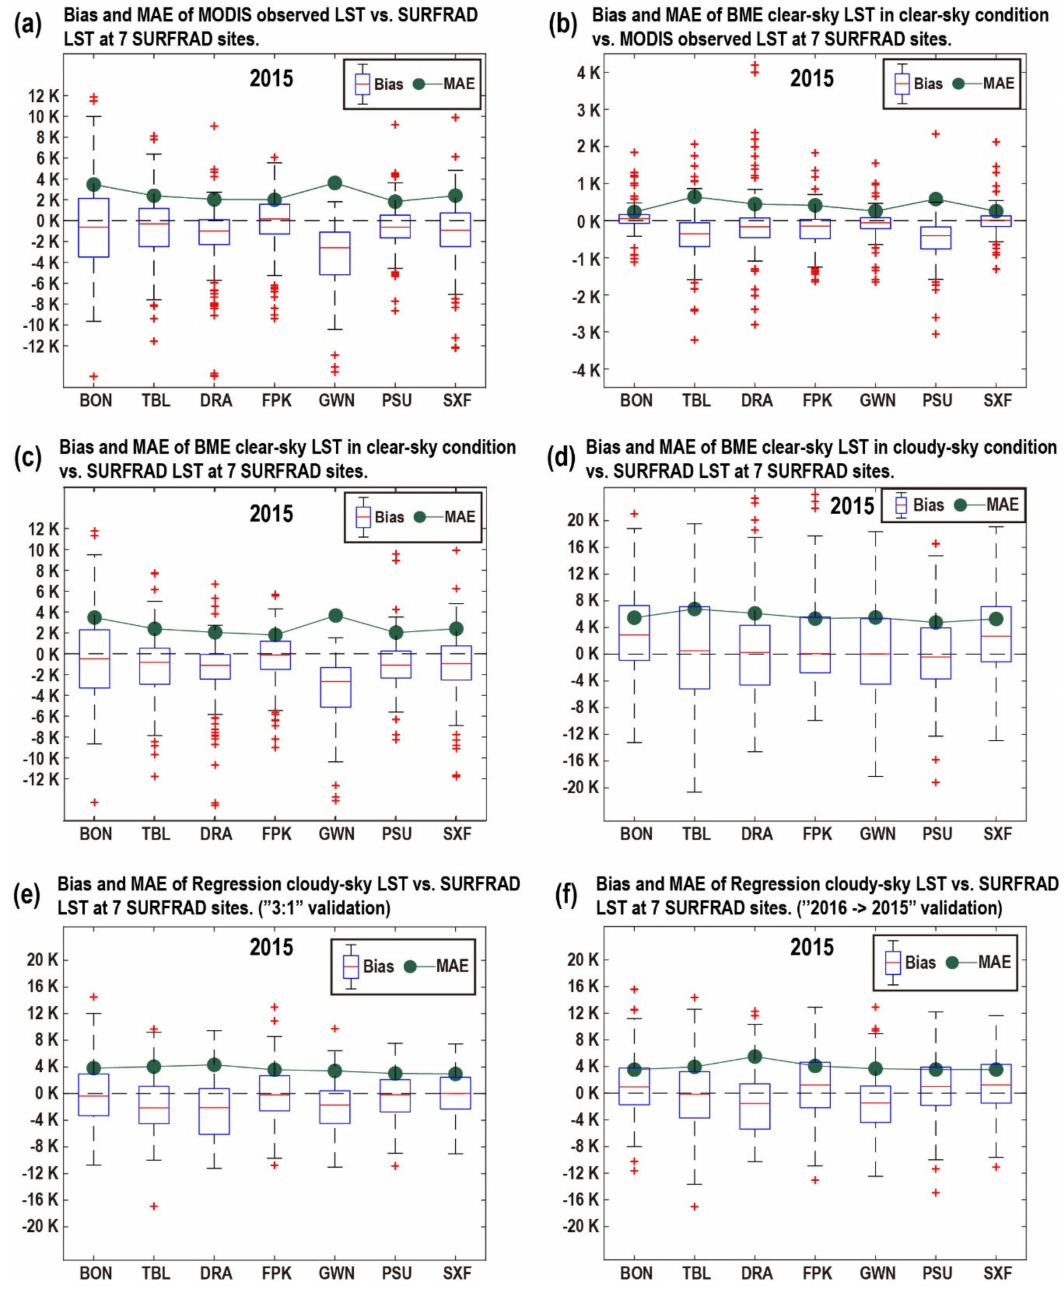
Figure 5. Bias and mean absolute error (MAE) of ( a ) MODIS observed LST versus SURFRAD LST, ( b ) BME clear-sky LST in clear-sky condition versus MODIS observed LST, ( c ) BME clear-sky LST in clear-sky condition versus SURFRAD LST, ( d ) BME clear-sky LST in cloudy-sky condition versus SURFRAD LST, ( e ) regression cloudy-sky LST versus SURFRAD LST (data from 2015 were randomly split into training and validation datasets at the ratio of 3:1), and ( f ) regression cloudy-sky LST versus SURFRAD LST (data from 2016 were used for training datasets and 2015 data for validation datasets) at 7 SURFRAD sites in